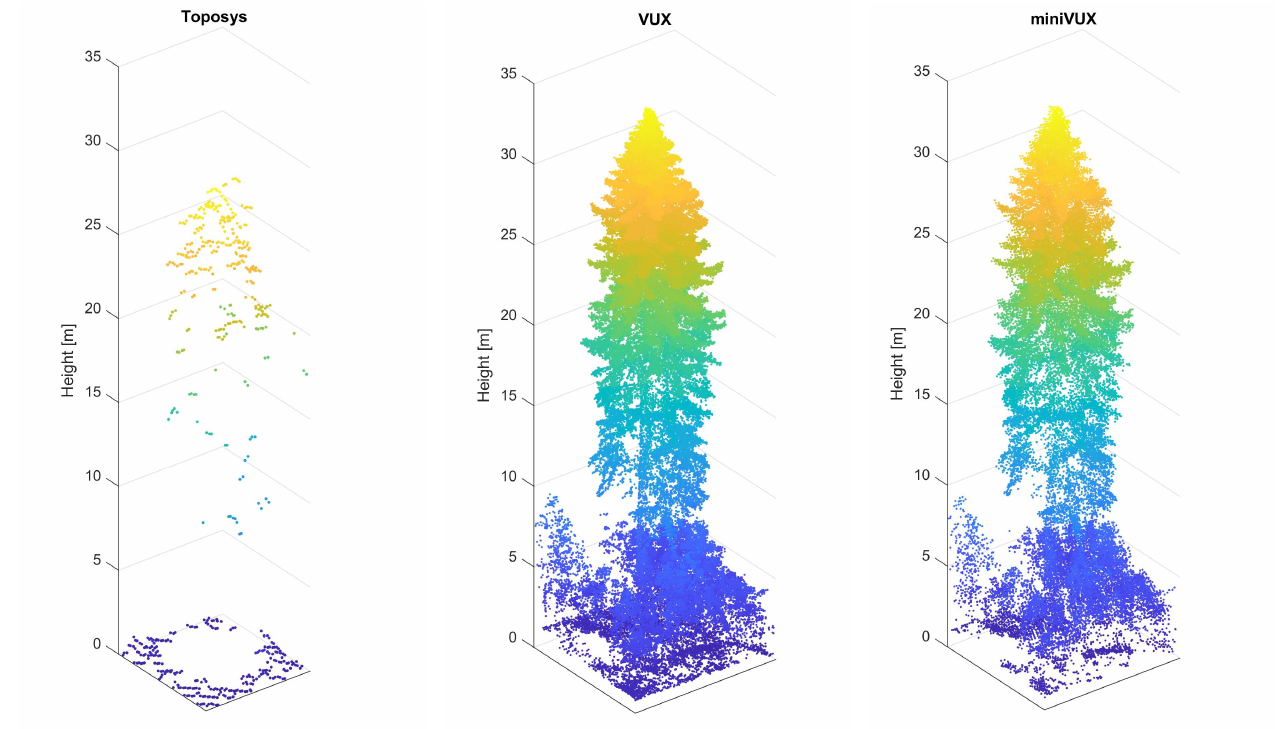
Figure 1. Point clouds of the same tree scanned in 2000 with Toposys and 2021 with VUX and miniVUX,